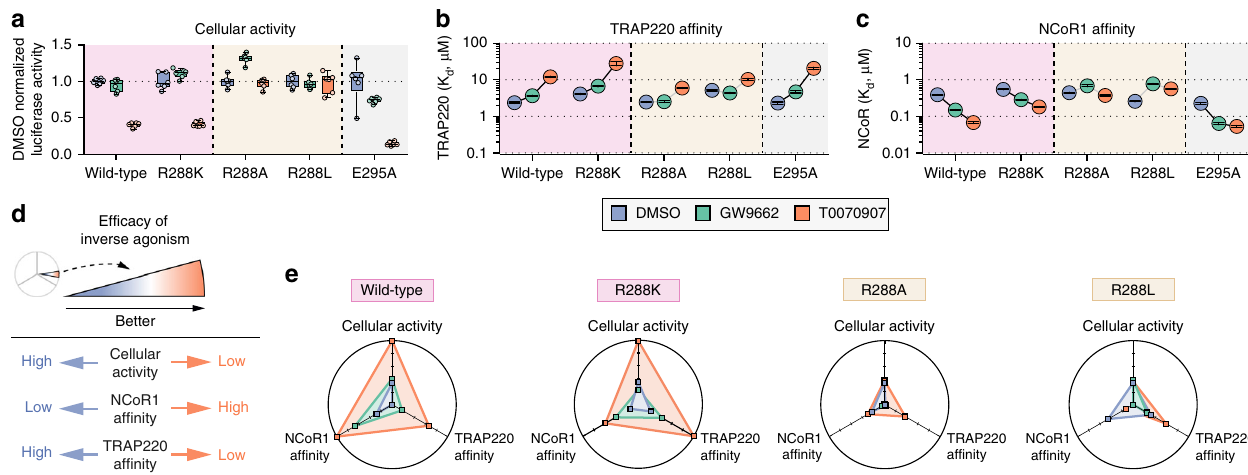
Fig. 4 Mutagenesis validates the R288-pyridyl interaction for conferring corepressor-selective inverse agonism. a HEK293T cells transfected with full- length PPAR γ expression plasmid along with a 3 × -PPRE-luciferase reporter plasmid and treated with the indicated ligands (5 µ M). Individual points ( n = 6) normalized to DMSO control (mean) are plotted on top of a box-and-whiskers plot; the box represents 25th, median, and 75th percentile of the data, and the whiskers plot the entire range of values. b , c Af fi nities determined from a fl uorescence polarization assay of wild-type and mutant PPAR γ LBDs preincubated with a covalent ligand (GW9662 or T0070907) or vehicle (DMSO) binding to FITC-labeled b TRAP220 or c NCoR1. Data plotted as the K d value and error from fi tting data of two experimental replicates using a one site binding equation. d Legend to the web of ef fi cacy radar chart diagrams. Corepressor-selective inverse agonism is associated with data points populating the periphery of the plots. e Radar web of ef fi cacy plots displaying assay data for wild-type PPAR γ and mutant variants. Data normalized within the range of values for each assay ( a – c ). Data are representative of at least